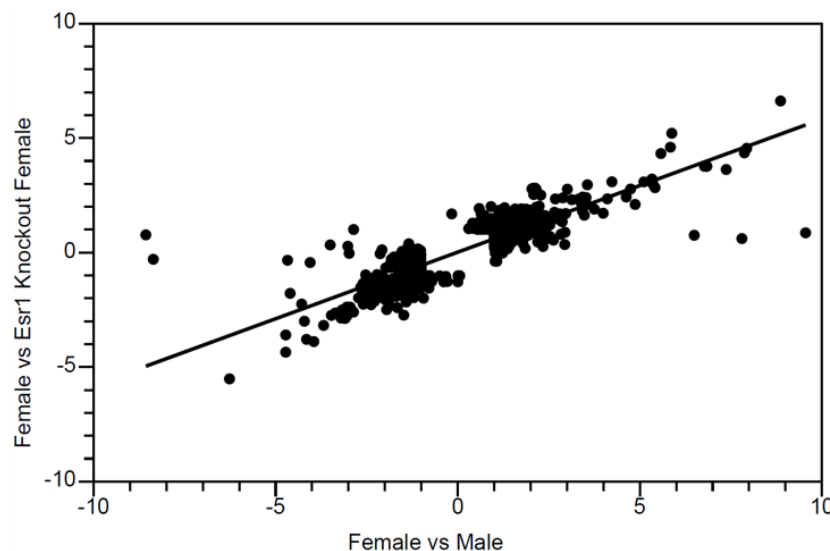
Figure 3. QPCR analysis of Estrogen Receptor- α -sensitive transcripts identified by microarray. RNA from the livers of 9–10 week-old mice was reverse transcribed and quantified by real-time PCR. WT females ( n = 5) were littermates of the Esr1 KO females. For Fmo3 , Sult3a1 , and Cyp4a12 the Esr1 KO female group was ( n = 5) and for 3 β -Hsd4/5 the Esr1 KO female group was ( n = 4). The average fold change and the standard error of the mean are shown. The ∆∆ CT method was used to calculate the fold change and standard error of the mean. The Wilcoxon rank sum test (two-sided) was used to test for changes in gene expression where each transcript was analyzed